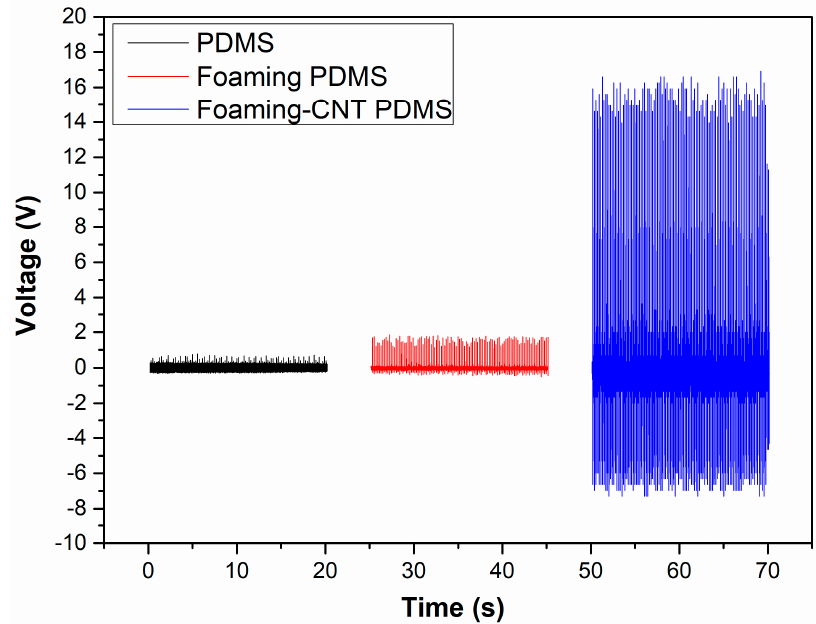
Figure 6. Voltage output patterns for TENG with pure PDMS, TENG with undoped porous PDMS, and TENG with CNT-doped porous PDMS.